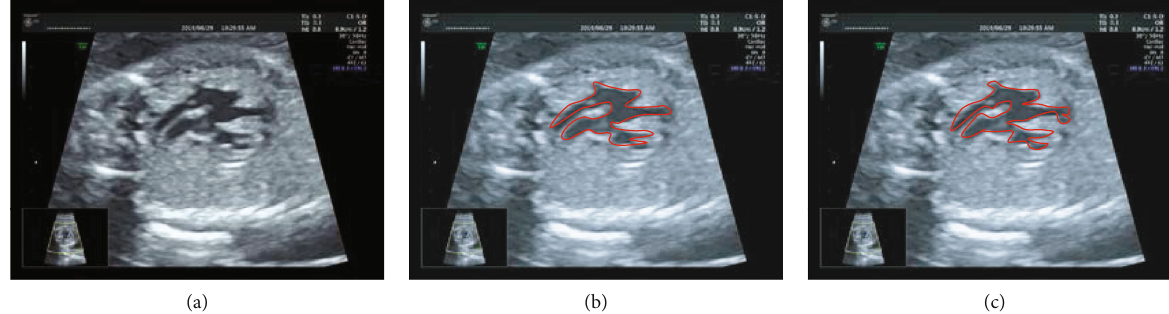
Figure 2: Segmentation of abnormal cardiac structures. (a) showed the original echocardiogram, (b) showed the segmentation e ff ect of the CNN algorithm, and (c) showed the segmentation e ff ect of the AI algorithm (the red curvilinear area referred to the segmented location of the lesion).